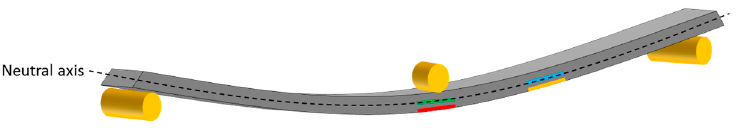
Figure 1. Representation of three points bending experiments with Quantum Resistive Sensor (QRS) placed in the tensile zone .